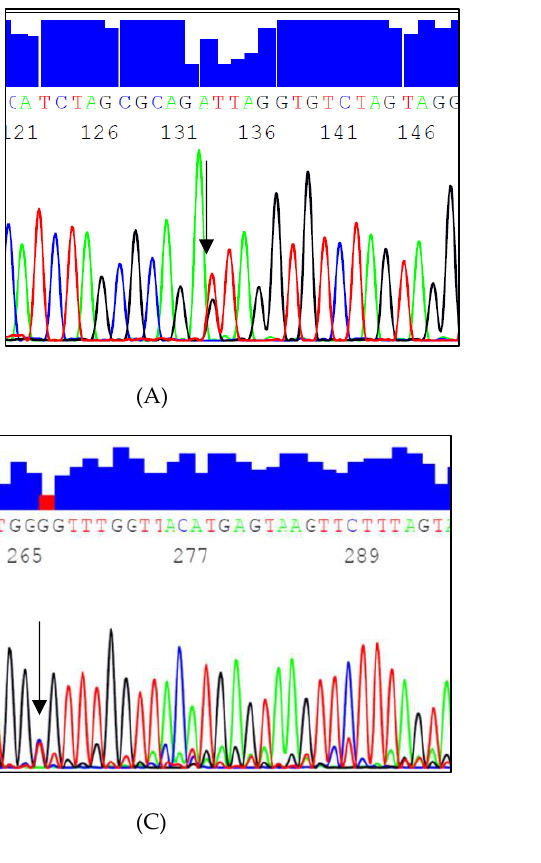
variations, c.1019-685_1019-684insA (rs293), c.1018+382_1018+383insT or c.1018+386_1018+387insA